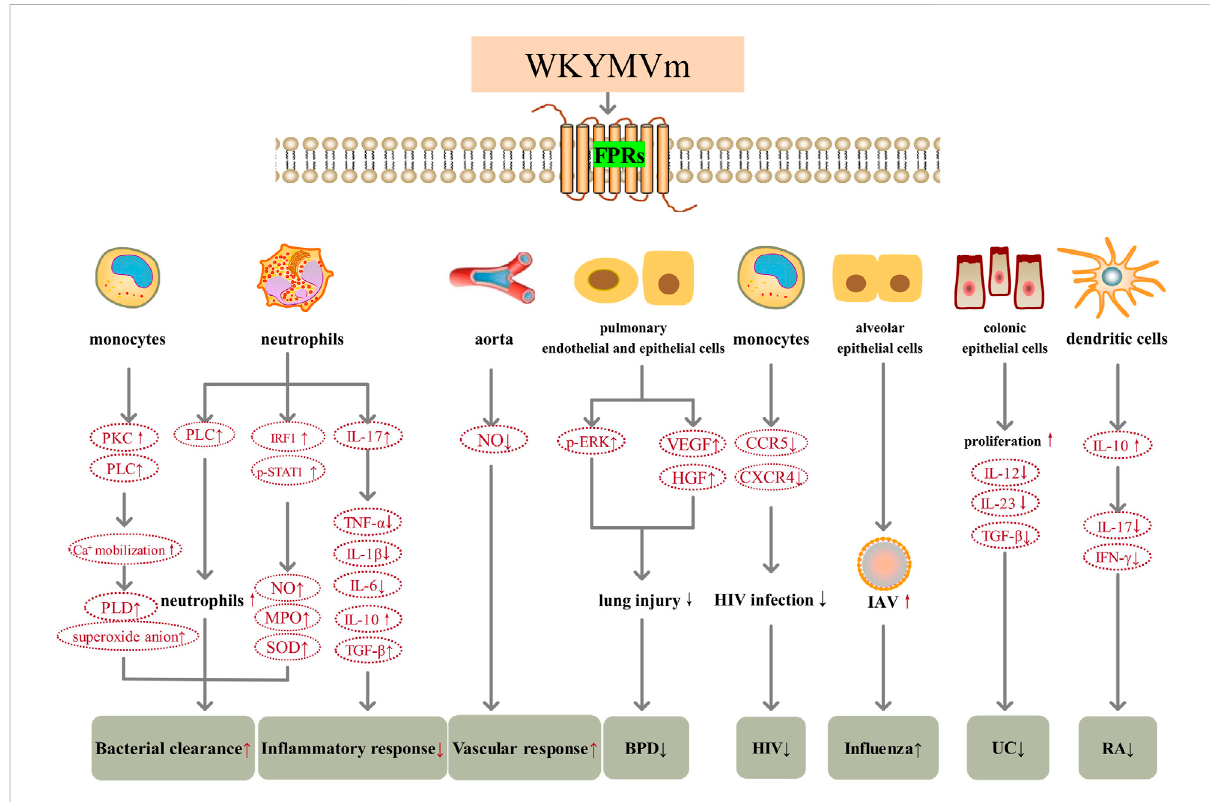
FIGURE 1 WKYMVm and in fl ammation. WKYMVm increases bacterial clearance by regulating the number of immune cells in the lesion and increasing various reactiveoxygen speciesproduction.WKYMVmdecreases in fl ammatoryresponsebymodulatingin fl ammatorycytokines.WKYMVmreverses vascular hyporeactivitybyreducingNO productionintheaortaof septicmice. WKYMVmupregulates thelevelsof ERK,VEGF andHGF,reduceslung injury in BPD. WKYMVm inhibits the function of CCR5 and CXCR4 on the surface of monocytes and reduces HIV infection. WKYMVm increases IAV replication and aggravates in fl uenza. WKYMVm stimulates colonic epithelial cells proliferation, reduces intestinal permeability, and downregulates in fl ammatory cytokines expression in UC. WKYMVm stimulates DCs to produce IL-10, decreases the production of IL-17 and IFN- γ , and alleviates cartilage destruction in RA. VEGF, vascular endothelial growth factor; HGF, hepatocyte growth factor; p, phosphorylation; ERK, extracellular signal-regulated kinase; BPD, bronchopulmonary dysplasia; CCR5, C-C motif chemokine receptor 5; CXCR4, C-X-C motif chemokine receptor4;HIV,humanimmunode fi ciencyvirus;IL,interleukin;TGF- β ,transforminggrowthfactor β ;UC,ulcerativecolitis;IAV,in fl uenzaAvirus;NO, nitric oxide; PKC, protein kinase C; IRF1, interferon regulatory factor1; STAT, signal transducer and activator of transcription; IFN- γ ,